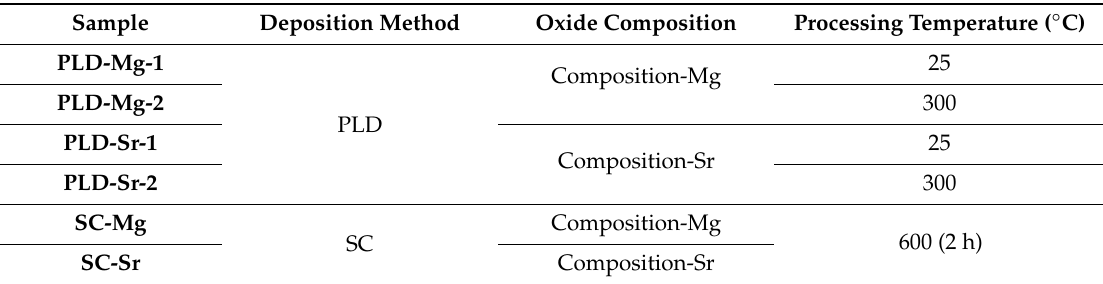
Table 2. Deposition details of the deposited